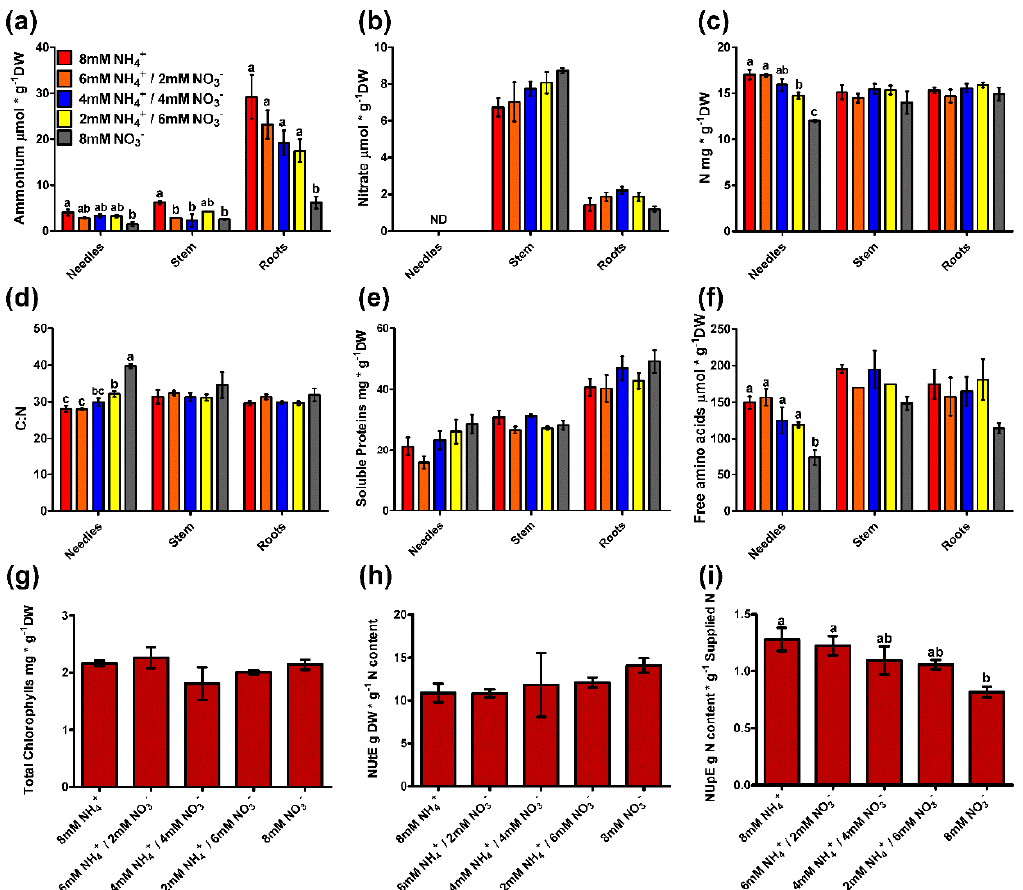
Figure 2. Profiles of plant N status markers in different organs (needles, stem, and roots) of pine seedlings under the nutrient treatments. ( a ) Ammonium content; ( b ) Nitrate content; ( c ) N content; ( d ) C:N ratio; ( e ) Soluble protein content; ( f ) Total free amino acid content; ( g ) Total chlorophyll content in pine seedling needles; ( h ) Nitrogen utilization efficiency (NUtE) in the seedlings under the different treatments; ( i ) Nitrogen uptake efficiency (NUpE) in the seedlings under the different treatments. Red columns correspond to 8 mM NH 4+ supply; orange columns correspond to 6 mM NH 4+ /2 mM NO 3- supply; blue columns correspond to 4 mM NH 4+ /4 mM NO 3 − supply; yellow columns correspond to 2 mM NH 4+ /6 mM NO 3 − supply; grey columns correspond to 8 mM NO 3 − supply. Significant differences were determined with a one-way ANOVA for each organ or entire seedling. Letters above the columns show significant differences based on a Newman-Keuls post-hoc test ( p < 0.05). Error bars show SE with n = 3.